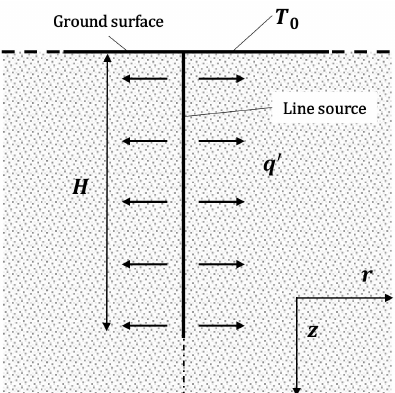
Figure 5. Scheme for TRT modeling with the finite line source (FLS)